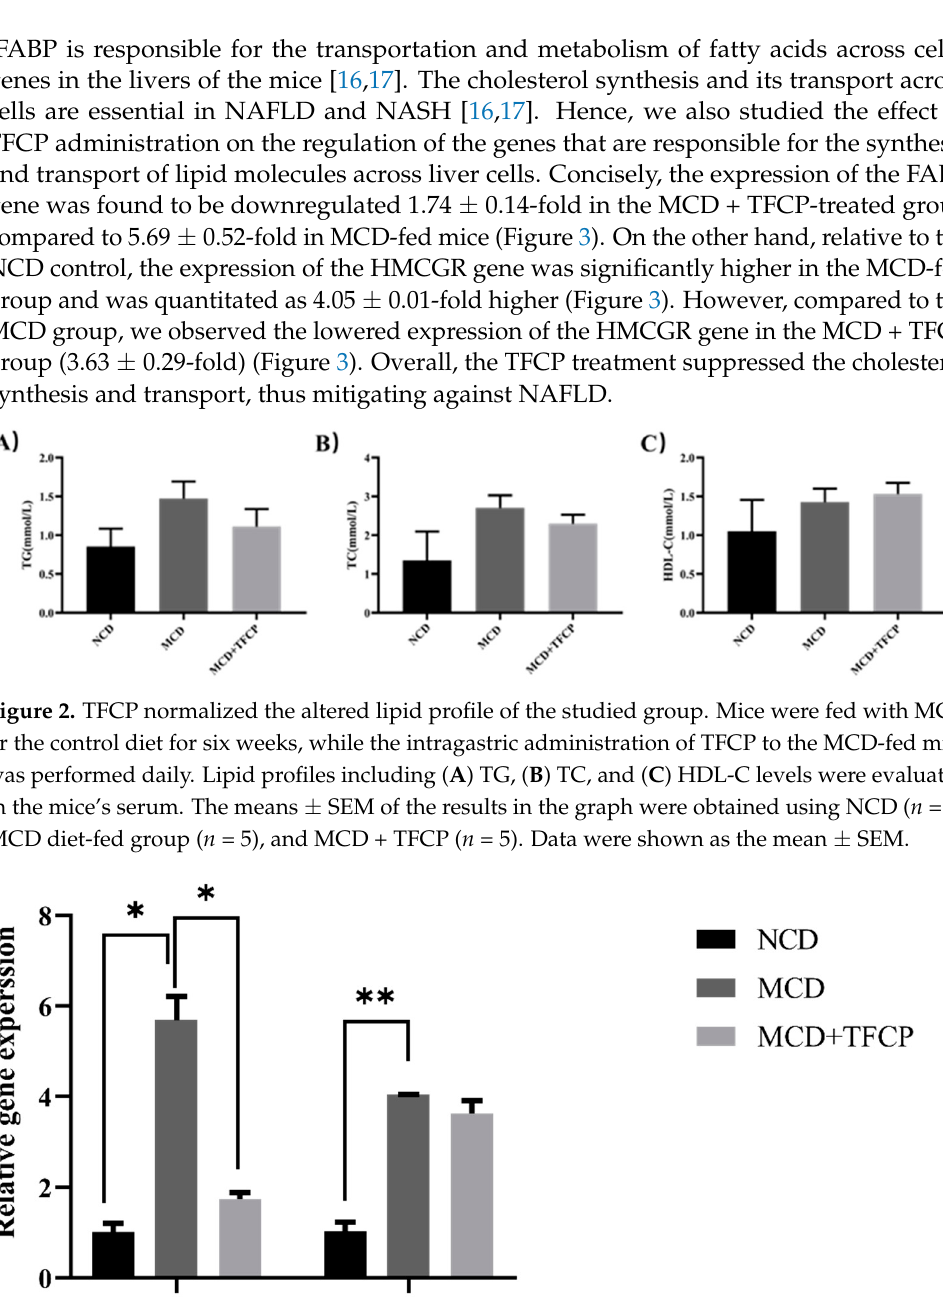
Figure 2. TFCP normalized the altered lipid profile of the studied group. Mice were fed with MCD or the control diet for six weeks, while the intragastric administration of TFCP to the MCD-fed mice was performed daily. Lipid profiles including ( A ) TG, ( B ) TC, and ( C ) HDL-C levels were evaluated in the mice’s serum. The means ± SEM of the results in the graph were obtained using NCD ( n = 5), MCD diet-fed group ( n = 5), and MCD + TFCP ( n = 5). Data were shown as the mean ± SEM.